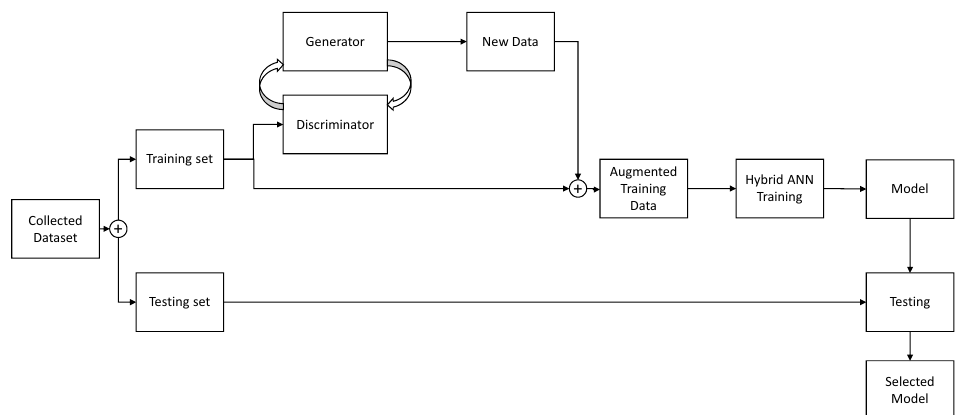
Figure 3. The process of Generative Adversarial Networks (GAN) use for a single image type is shown. Data is split into training and testing sets, and training set is used to generate additional images. Generated images are mixed with existing dataset and used for training, generating models which are finally evaluated on the testing